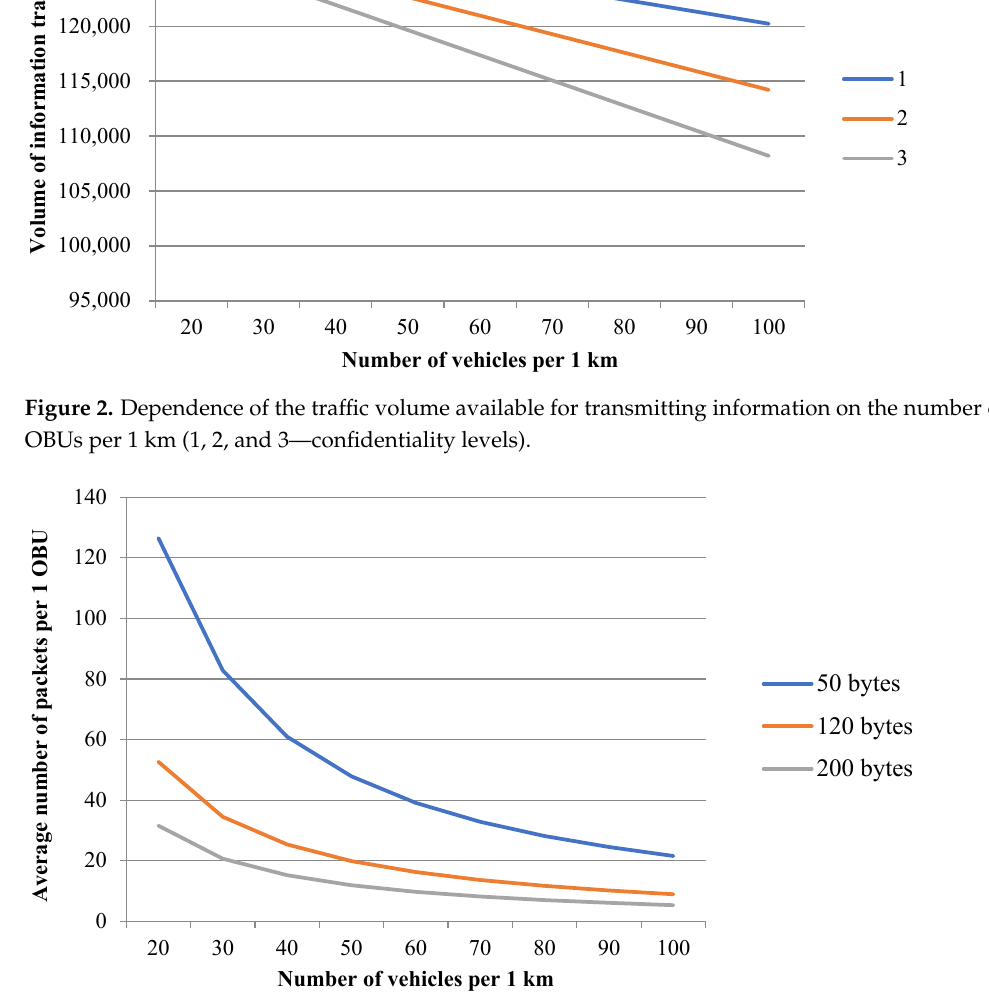
Figure 3. The average number of packets per OBU at the 3rd confidentiality level, 64-bit authentication protocol.